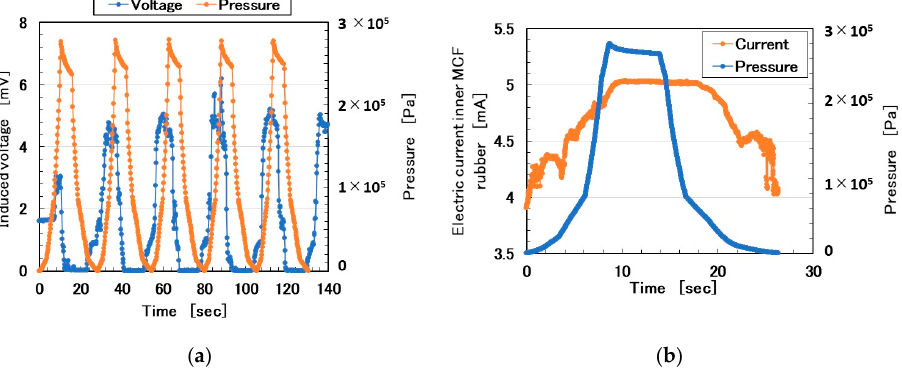
Figure 1. Electrical property of magnetic compound fluid (MCF) rubber sensor in response to repeating pressure: ( a ) for piezo-electricity; ( b ) for piezo-resistivity.